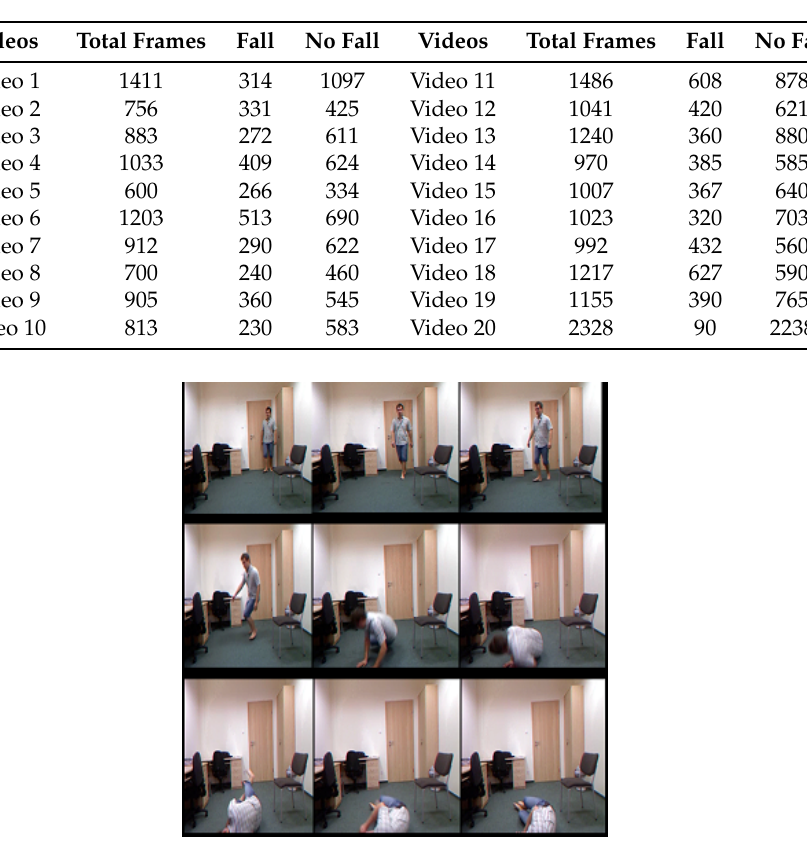
Figure 3. Selected frames from the frontal sequence of the URFD